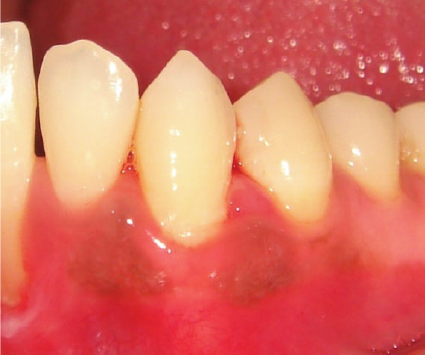
Figure 2: Exophytic and hemorrhagic lesion in the lower canine- premolar region (lingual view).